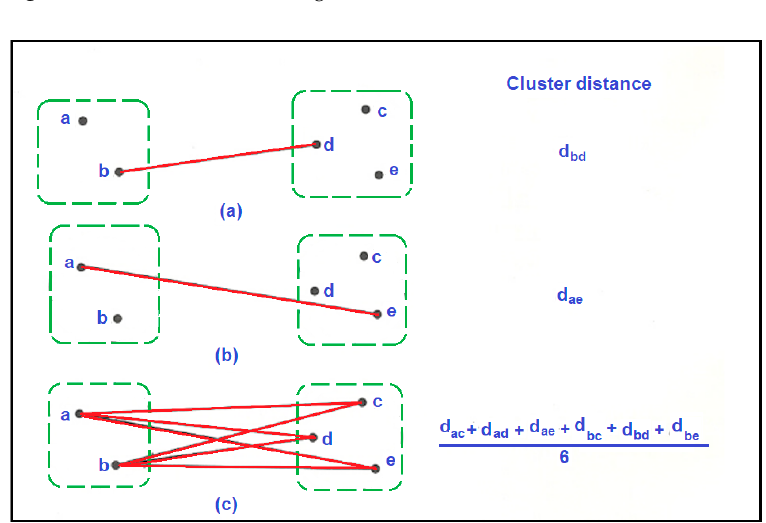
Figure 2. Intercluster distance (dissimilarity) for ( a ) single linkage, ( b ) complete linkage, ( c ) average linkage.